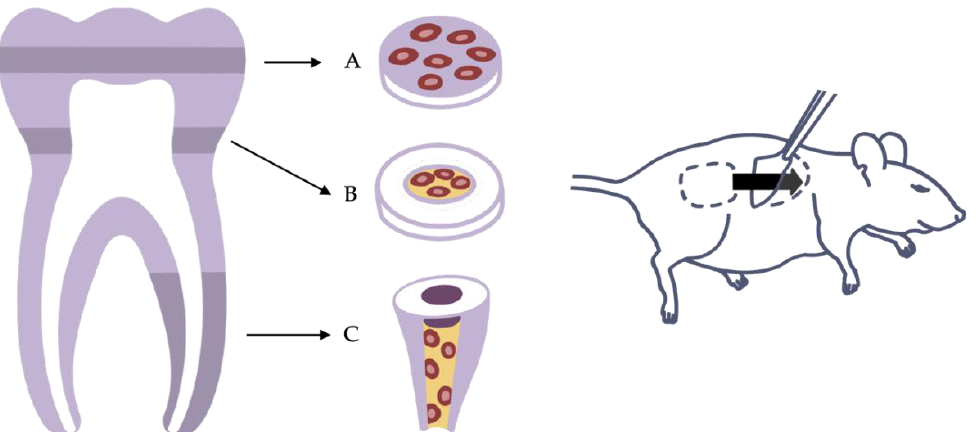
Figure 4. Variants of the ectopic transplantation model. ( A ) Dentin disk with cells seeded on top. ( B ) Tooth slice with cells and scaffold inserted into the pulp chamber. ( C ) Root fragment model with cells and scaffold inserted into the root canal.